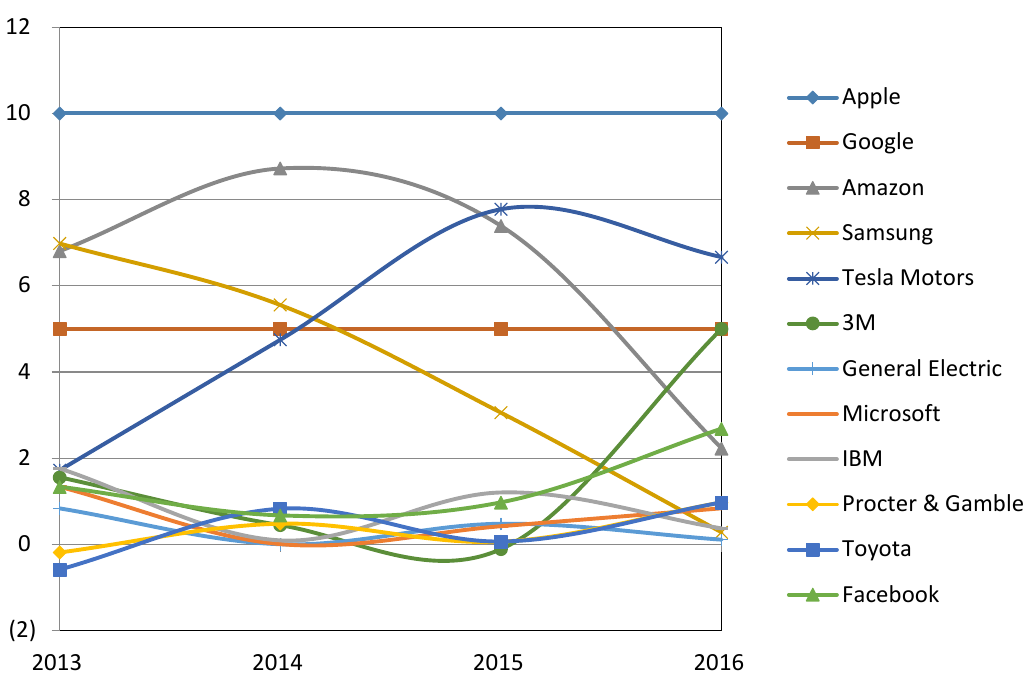
Figure 2. The 3-year running average of the Innovation Power of each of the top 12 innovators over the four-year period from 2013 through